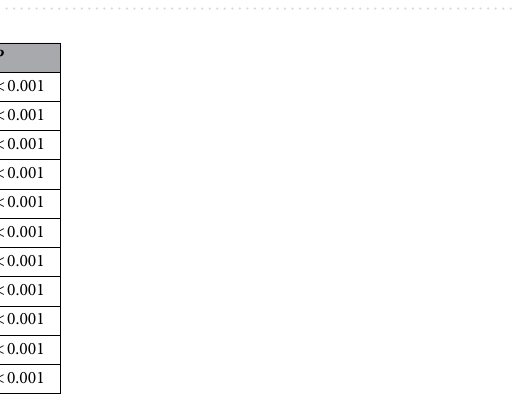
Figure 6. Space–time scanning analysis of reported cases of pulmonary tuberculosis in China from 2014 to 2018.